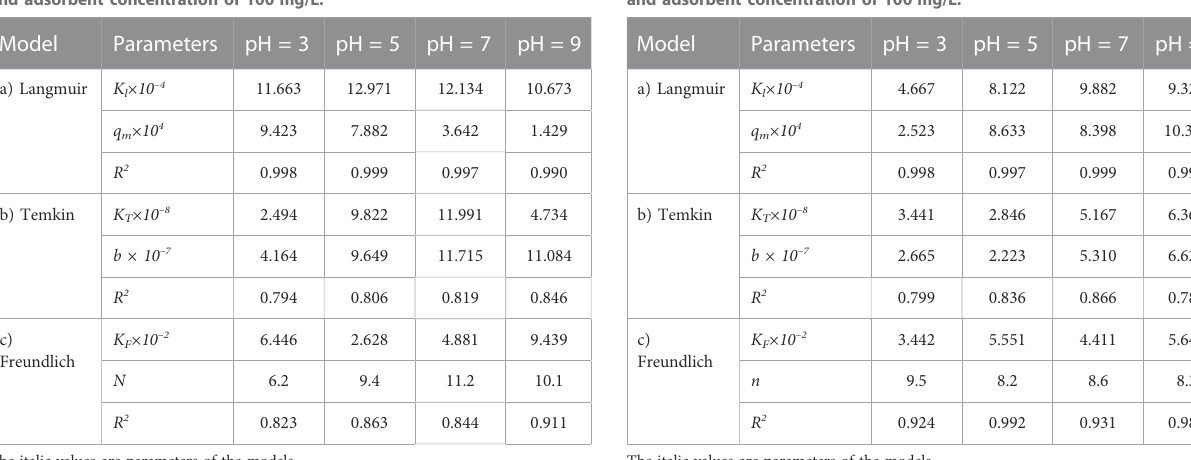
TABLE 9 Parameters of a) Langmuir, b) Temkin, and c) Freundlich isotherm models at different pH values using Oil sludge 2 as carbon active at T = 318 K and adsorbent concentration of 100 mg/L.